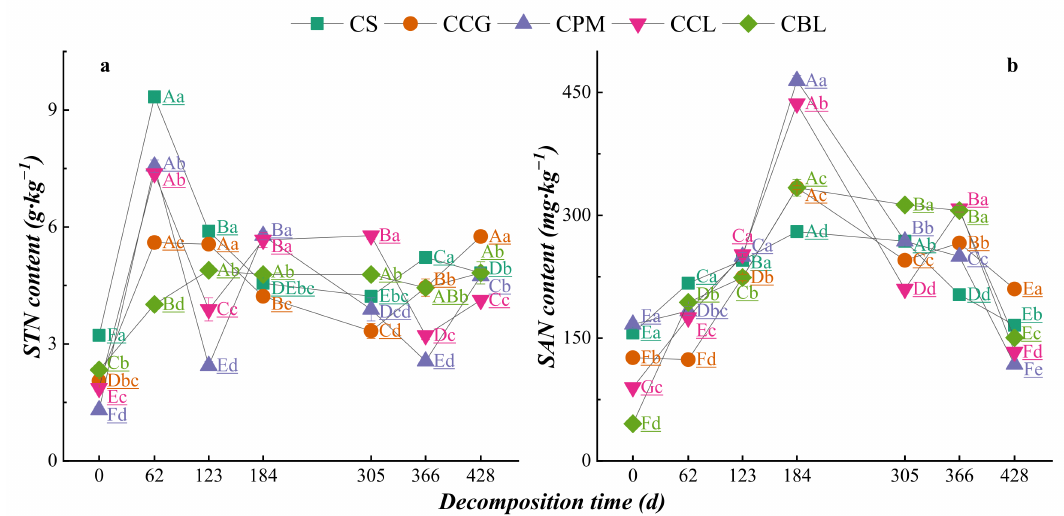
Figure 7. Dynamic changes in soil N contents of different plant residues during decomposition processes. Note: A, B, C—differences between decomposition stages of the same treatment ( p < 0.05); a, b, c—differences between treatments in the same decomposition period ( p < 0.05); ( a )—STN content (g-kg − 1 ); ( b )—SAN content (mg-kg − 1